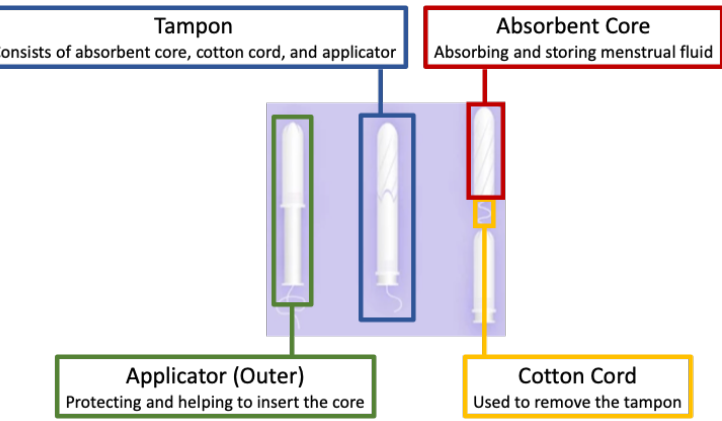
Figure 1. Components of tampons—absorbent core, cotton cord, and